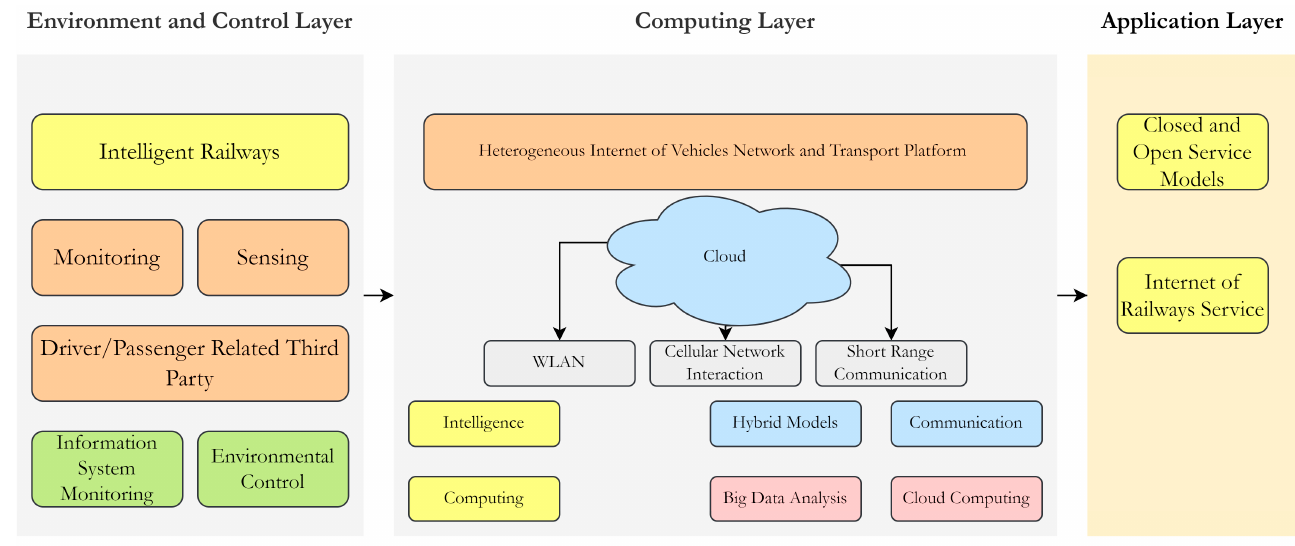
Figure 1. Key Components of Internet of Railways.